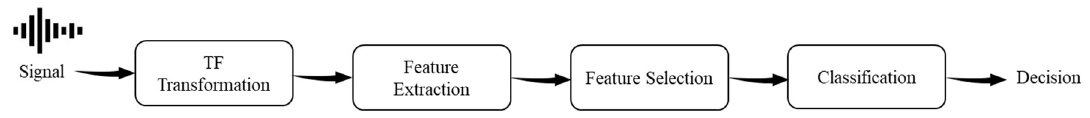
Figure 2. Time-frequency (TF) approach for pattern classification.